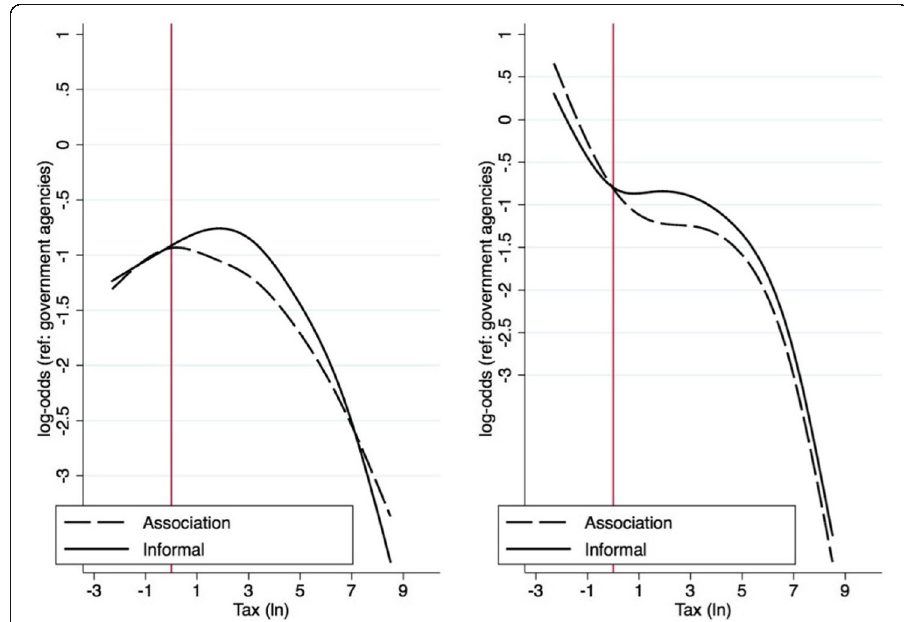
Fig. 2 Size of private enterprises and strategy selection. The solid line stands for the log-odds of choosing informal strategies against the directly communicating with government agencies. The dashed line stands for the log-odds of choosing associational channels against the directly communicating with government